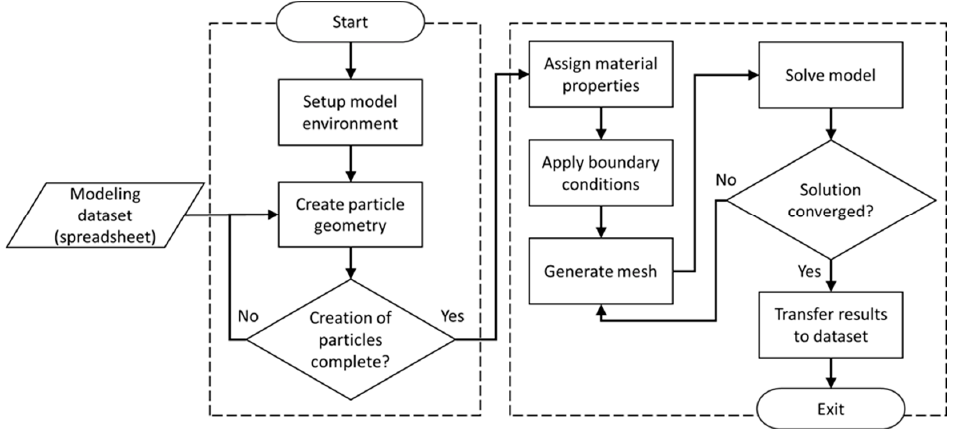
Figure 4. Schematic illustrating the algorithm for the FEA module [58].